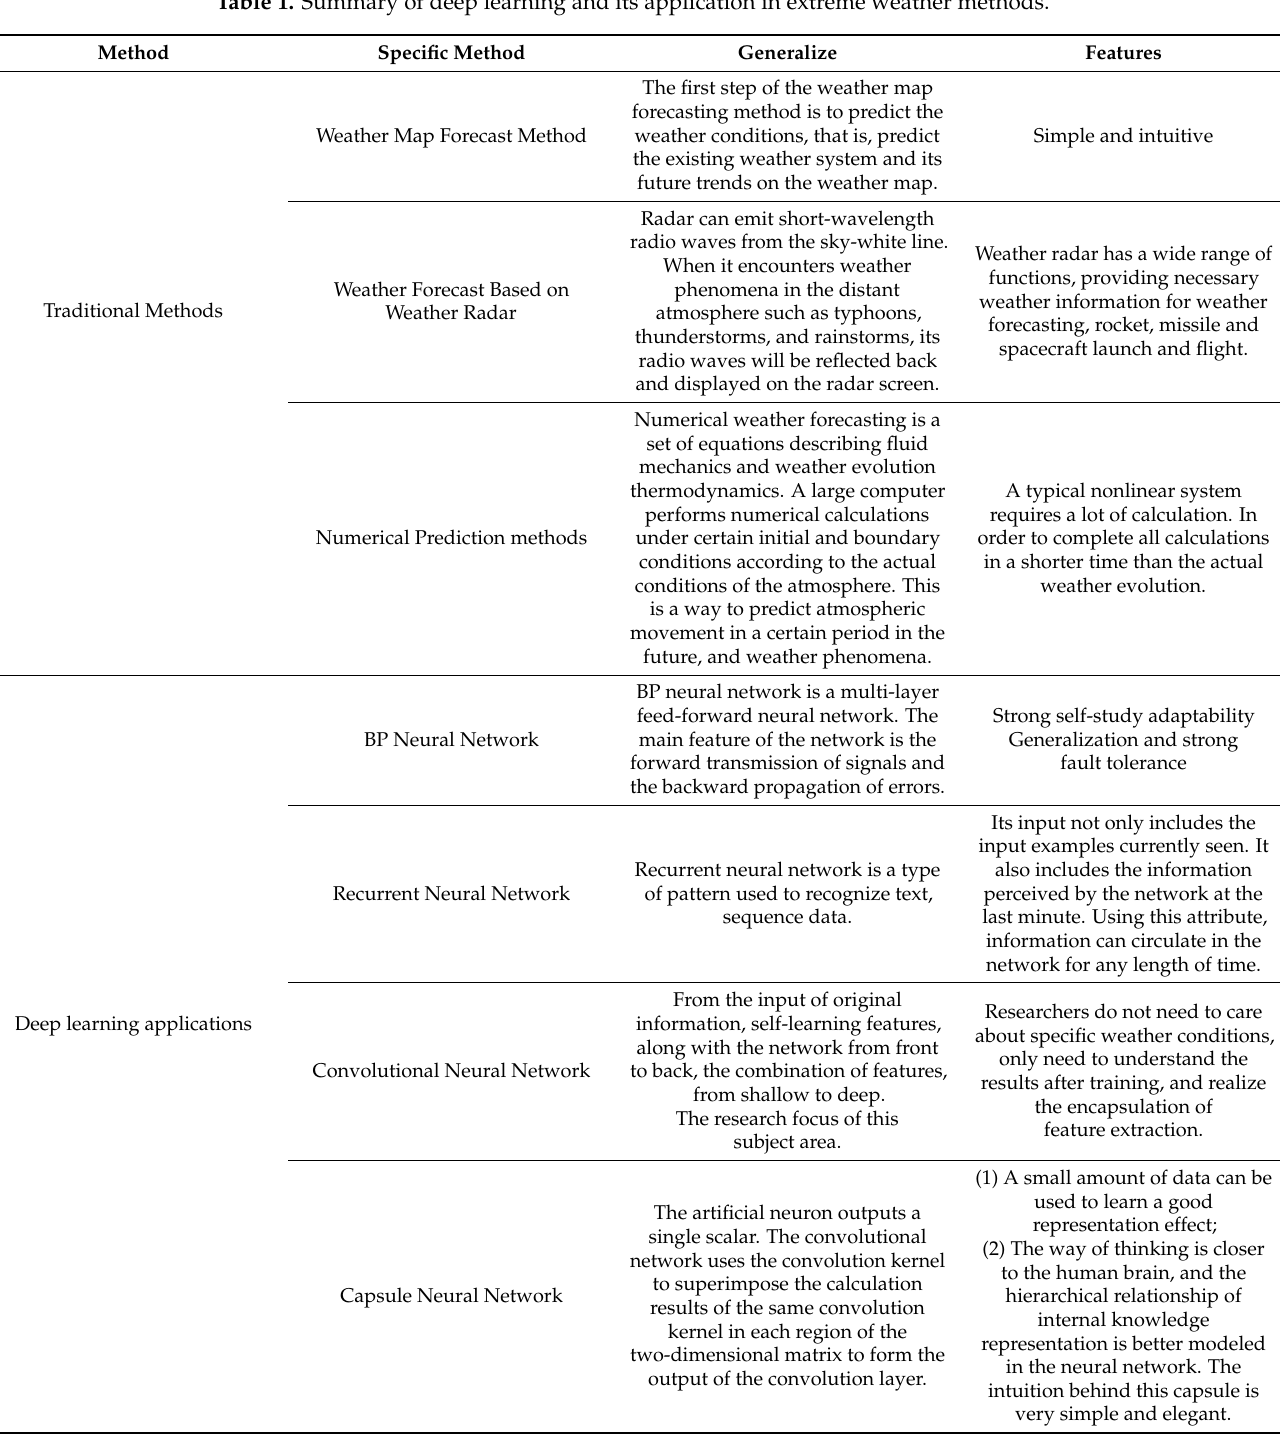
Table 1. Summary of deep learning and its application in extreme weather